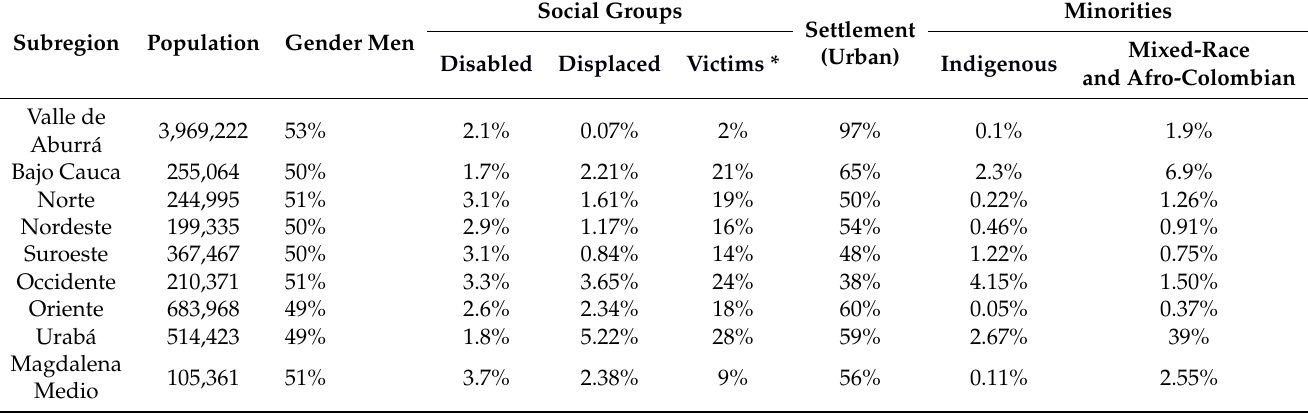
Table 2. Distribution of the population that corresponds to the demographic groups in each subre- gion [20–24]. * There are 1,307,620 victims reported in Antioquia (nearly 20% of the population); even so, 704,811 of them are not georeferenced